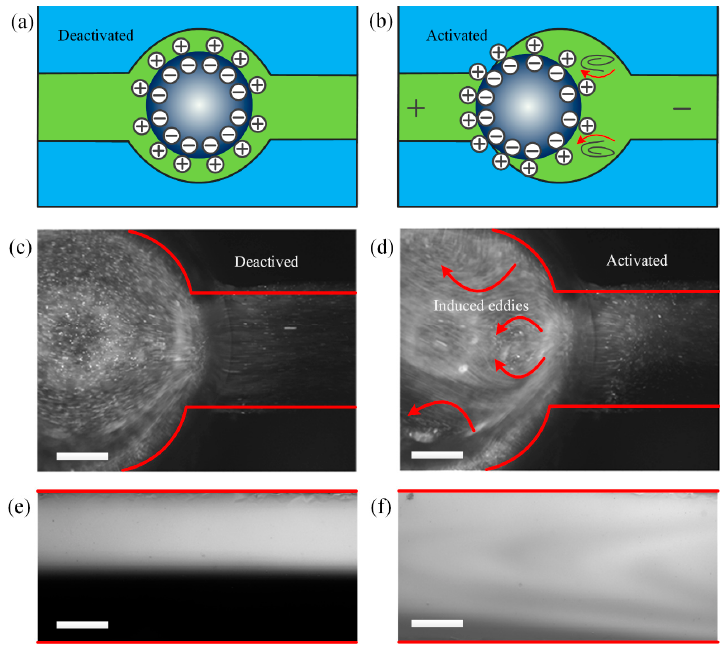
Figure 2. Working mechanism of the liquid metal droplet based high throughput microfluidic mixer. ( a ) Schematic of the electric charge distribution over the surface of the liquid metal droplet when immersed in NaOH solution; ( b ) schematic of the electric charge redistribution and the induced eddies over the surface of the liquid metal droplet along with the application of external electric field (note the fluid motion is caused by Marangoni effect but not Coulomb force within the diffuse double-layer); ( c , d ) microscopic optical image of fluorescent particle trajectories along the surface of the droplet observed from the top by the high speed camera before and after a sinusoidal wave of 6 Vpp and 100 Hz is activated between the two electrodes; ( e ) microscopic view of the flow pattern before the mixer is activated; ( f ) microscopic view of the flow pattern after the application of the electric field. The scale bar on each image is 500 μ m.